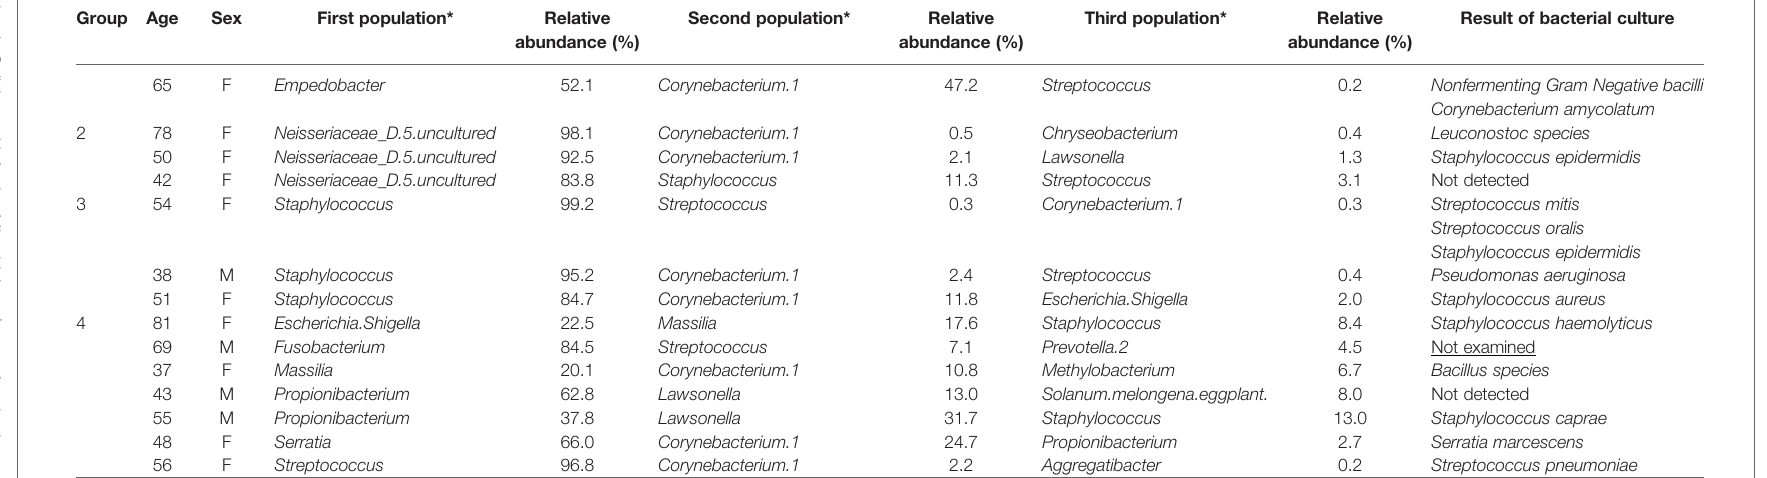
*Bacterial genera were ranked from those with high